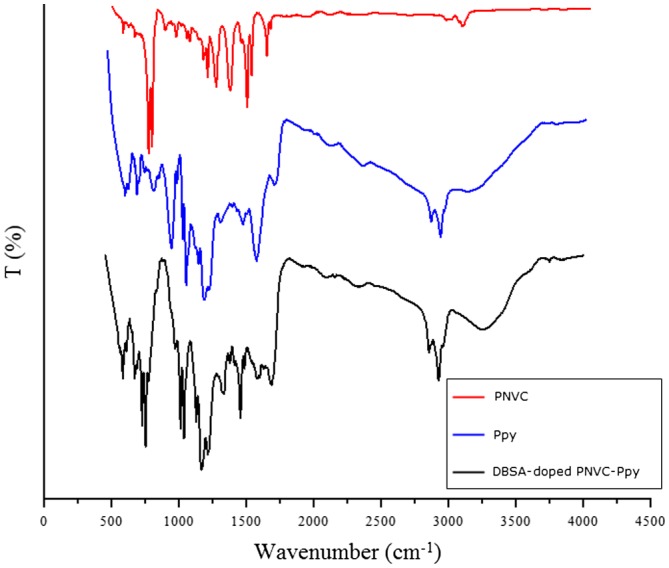
FTIR spectrum of PNVC, Ppy, and DBSA-doped PNVC–Ppy.